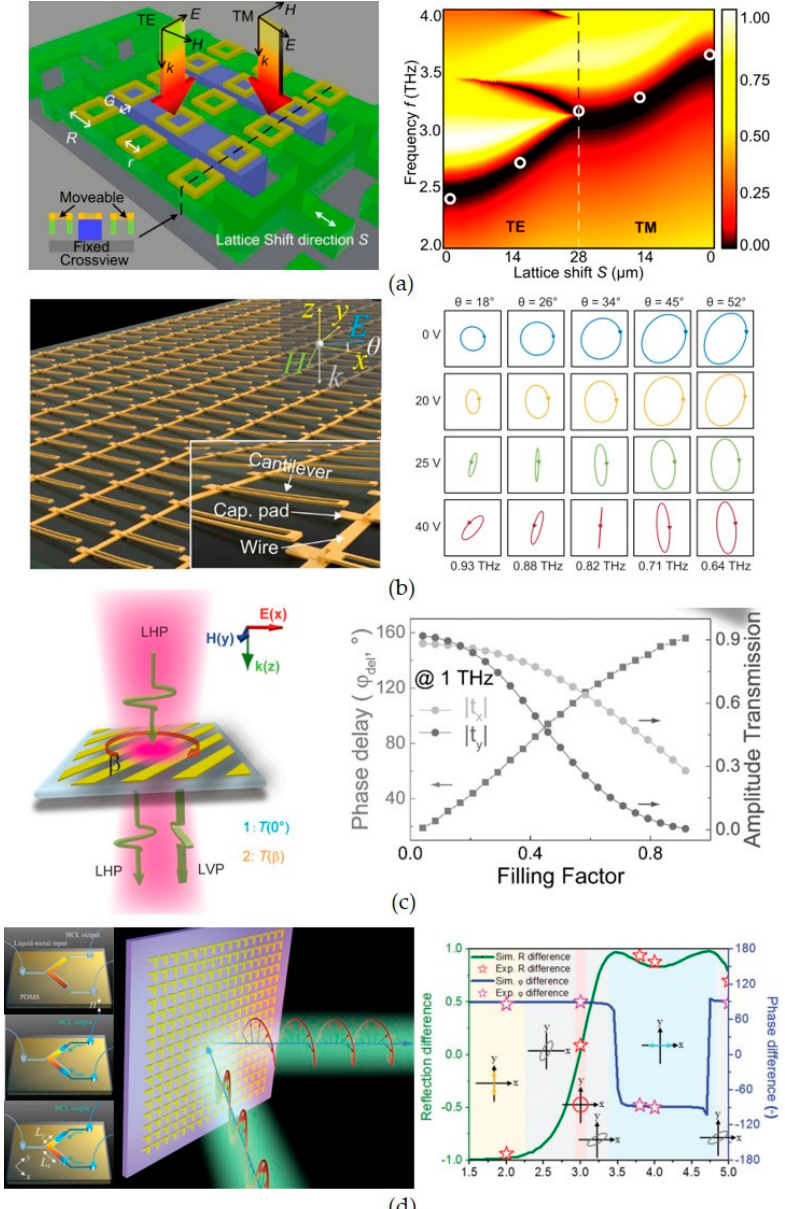
Figure 2. MEMS metasurfaces for polarization control. ( a ) Polarization dependent state tuning via symmetry breaking of metasurface lattice; ( b ) controllable polarizer driven by electrostatic force; ( c ) metasurface polarizer with flexible substrate; ( d ) controllable polarizer. Figure 2a–d are reprinted with permission from [64] copyright by AIP, 2011, [64] copyright by OSA Publishing, 2018, [66] respectively.